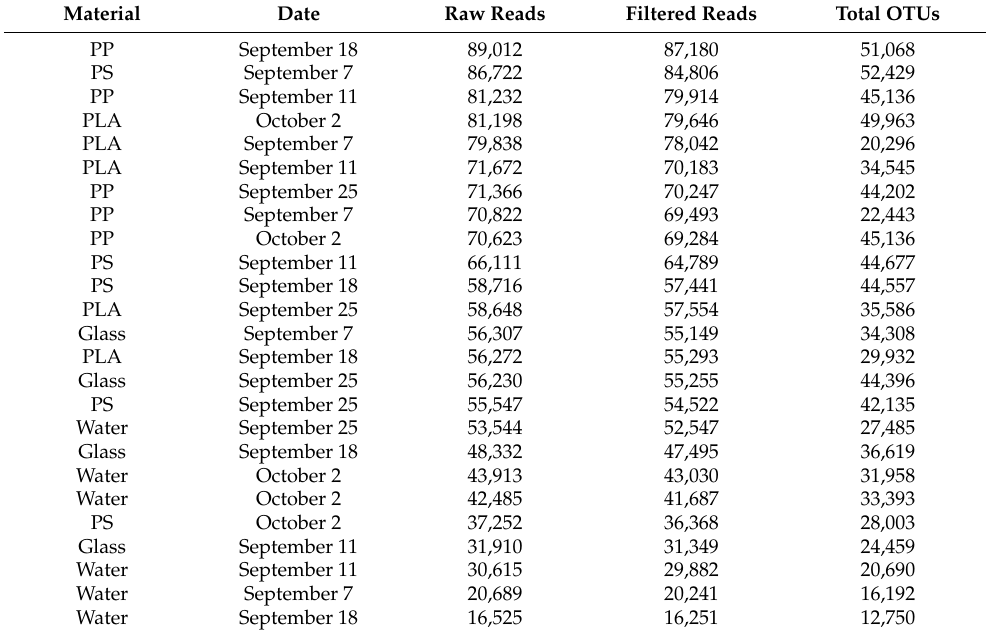
Table 1. Number of raw reads, number of reads after filtration, and total number of OTUs per sample.